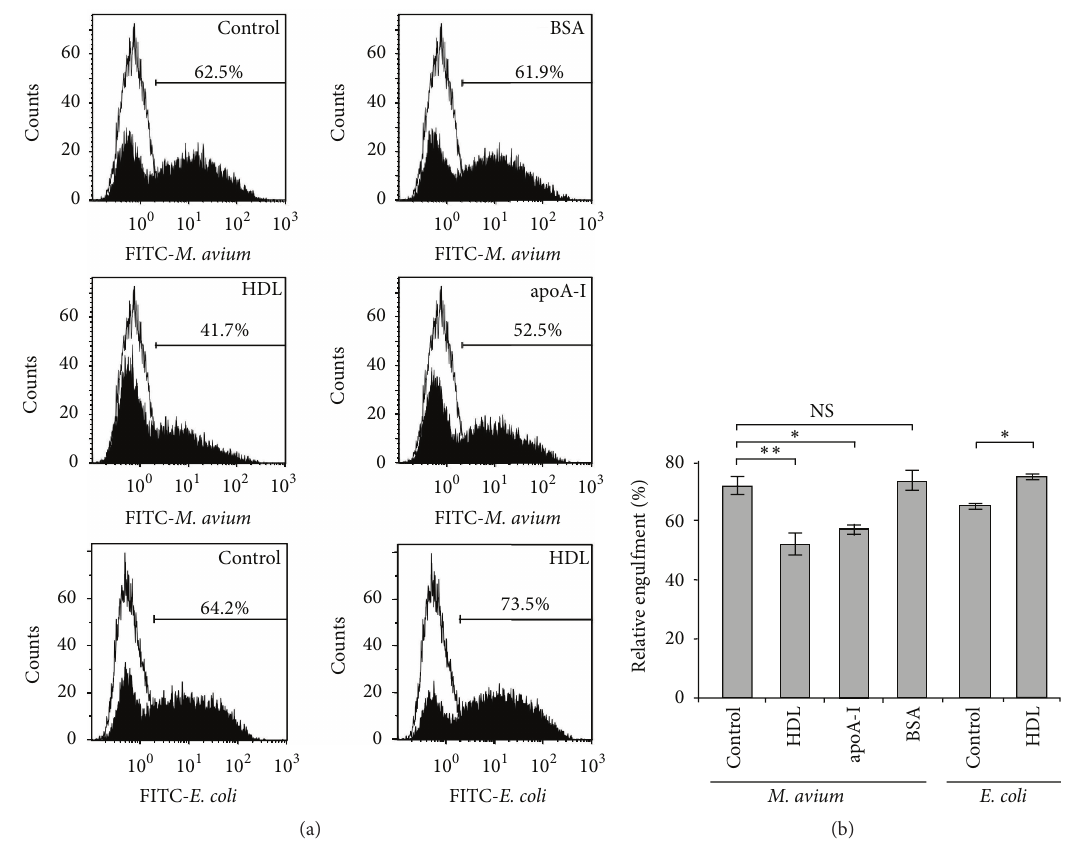
Figure 4: Effects of HDL on the engulfment of M. avium by THP-1 macrophages. (a) THP-1 macrophages (10 6 /well) were cultured with FITC- conjugated M. avium or E. coli in the presence or absence (control) of HDL (50 𝜇 g protein/mL), apoA-I (50 𝜇 g/mL), or BSA (50 𝜇 g/mL) for 24 h. After extensive washing and quenching of extracellular bacteria, the cells were subjected to flow cytometric analysis. Representative scatter profiles are presented. (b) The percentages of FITC-positive cells compared to the control using FITC- M. avium or FITC- E. coli were quantitatively compared. The values were indicated by mean ± SEM ( 𝑛 = 3 , ∗ 𝑃 < 0.05 , ∗∗ 𝑃 < 0.01 ). NS: not